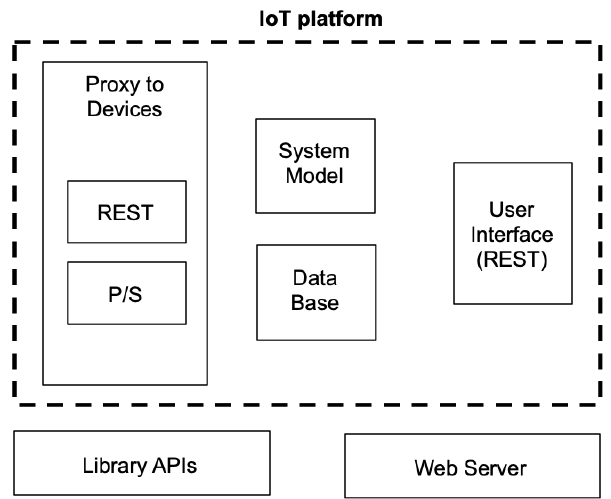
Figure 2. The structure of IoT